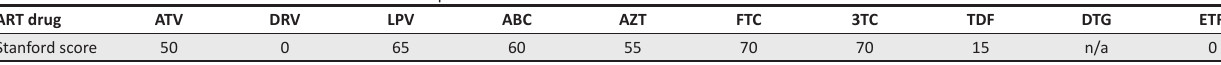
TABLE 2: Stanford score based on the observed resistance